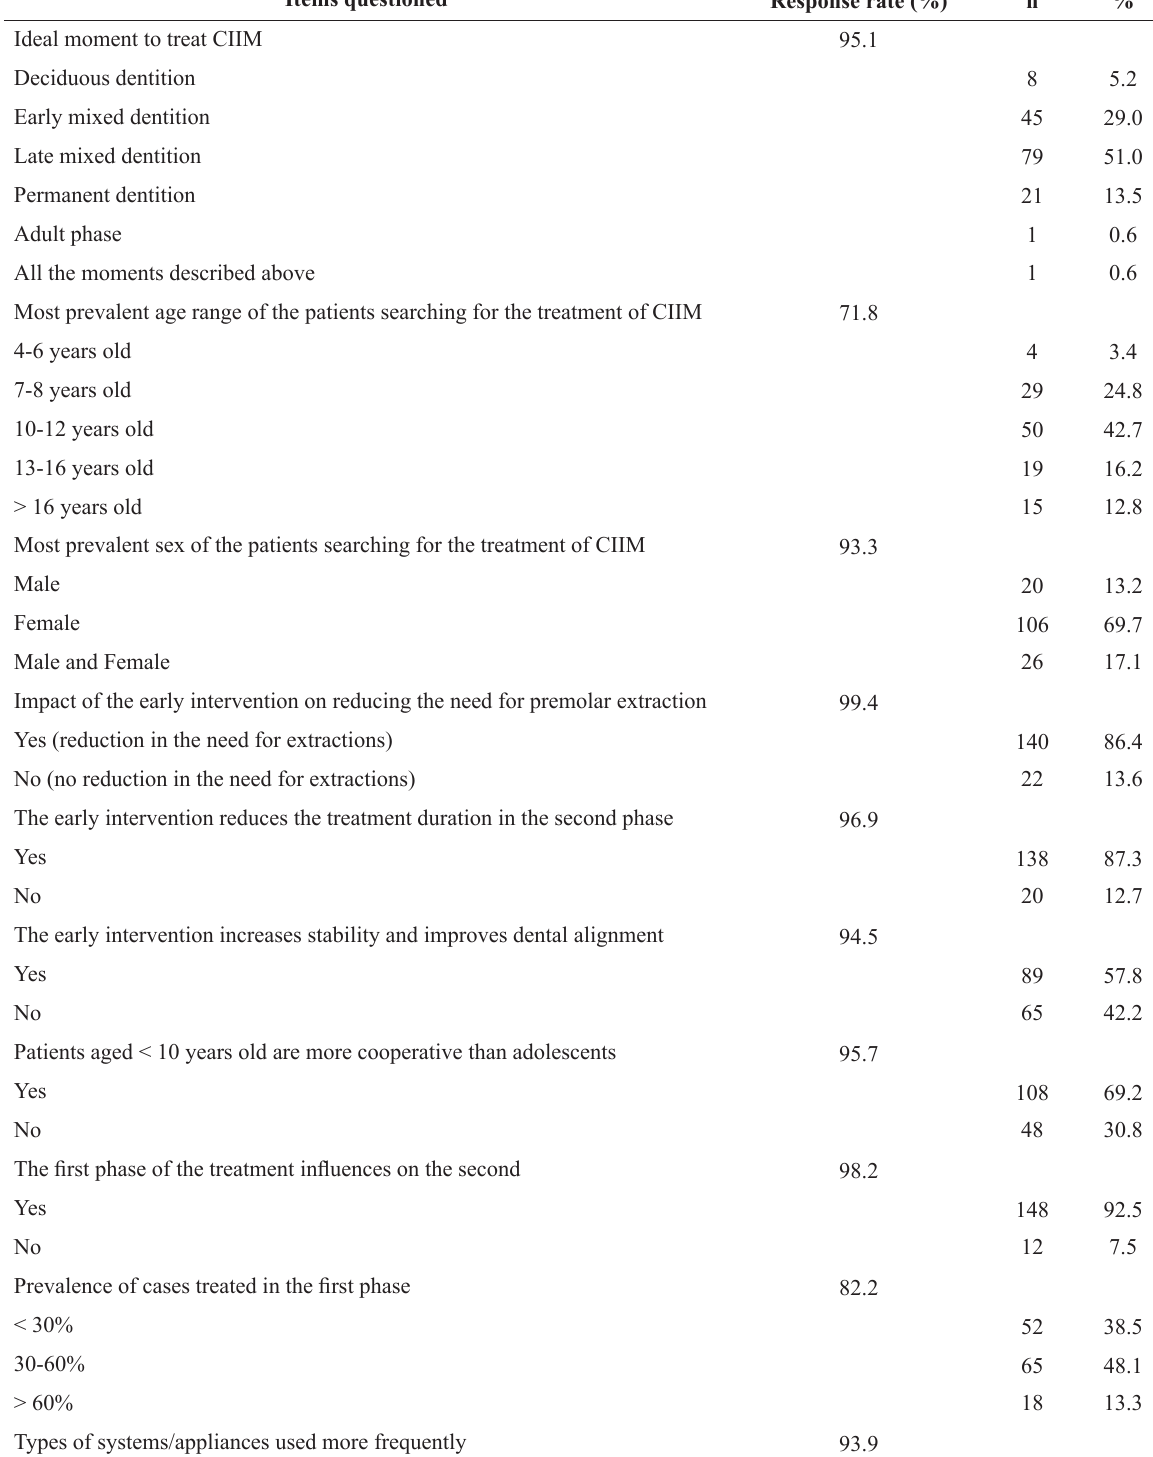
Outcomes of the questions concerning the treatment of Class II